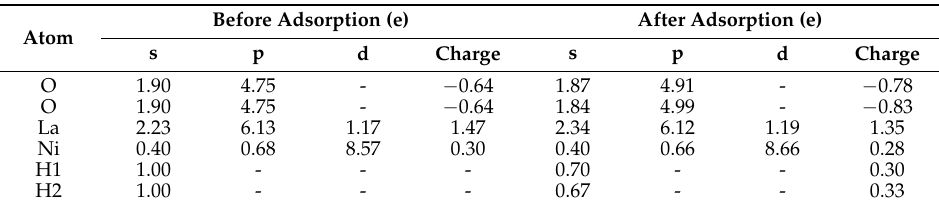
Table 5. The calculated electron populations of LaNiO 3 (001)/H 2 on B3.